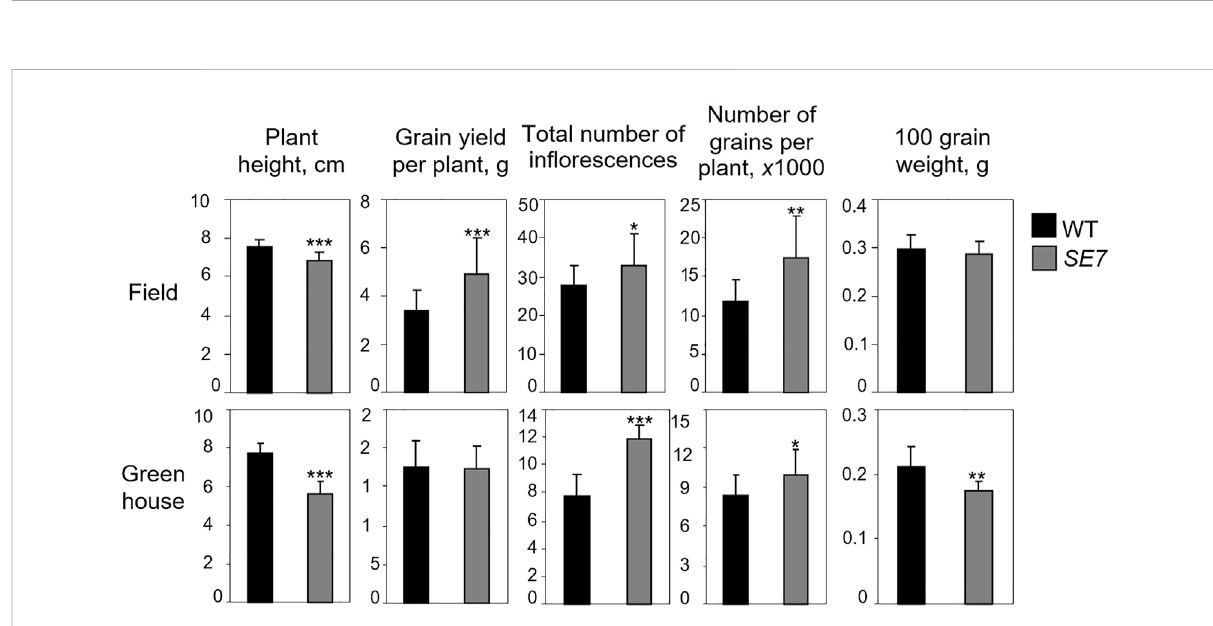
FIGURE 8 Productivity trait difference of fi eld-grown (upper panel) and greenhouse-grown (lower panel) SE7 somaclonal mutant plants compared to the wild type of fi nger millet. Statistically signi fi cant differences are marked with * — signi fi cant at p < 0.05; ** — p < 0.01; *** — p < 0.001.